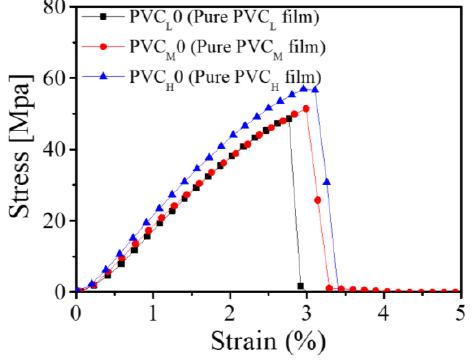
Figure 4. Mechanical property of the pure PVC films.